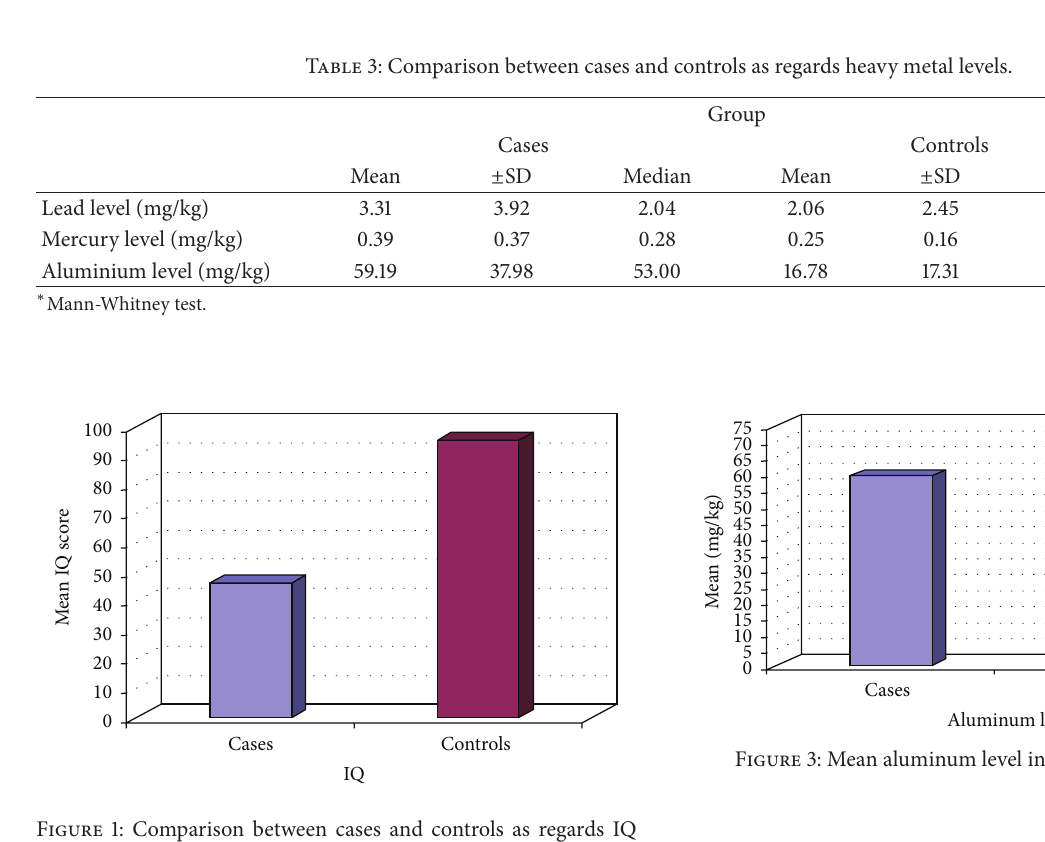
Figure 1: Comparison between cases and controls as regards IQ score, 𝑃 = 0.0001 , Student’s t -test.